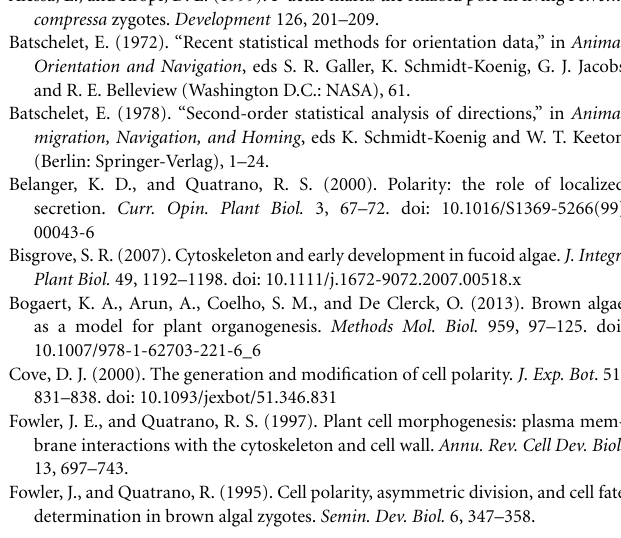
deposition as assayed by TBO staining. Hours denote duration of illumination under different light regimes and therefore the strength of each vector. Black bars and spheres denote the polar endomembrane system and F-actin deposition symbolizing the entire axis amplification